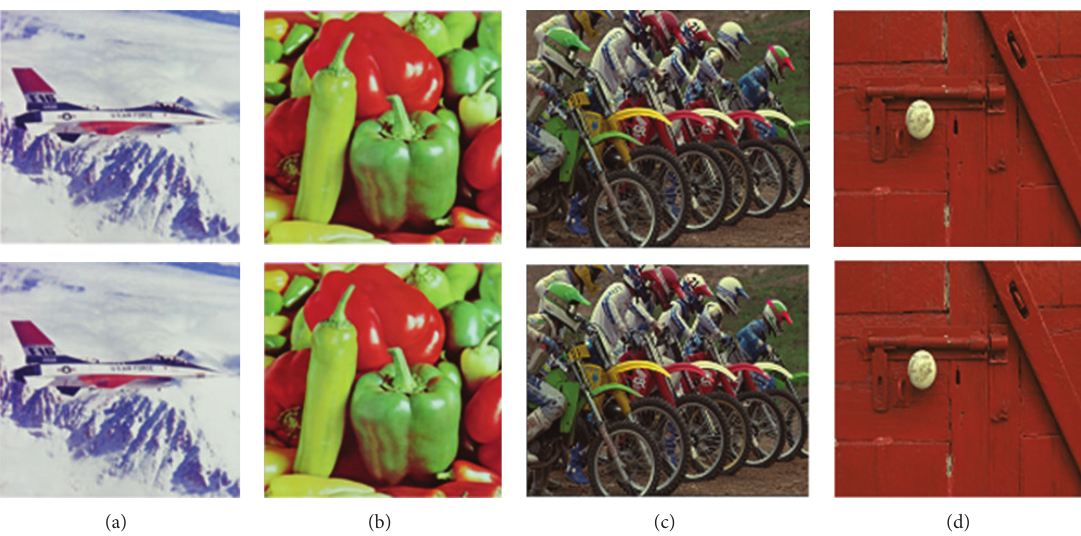
Figure 7: Comparison with H.264/AVC with QP = 24. (a) Jet (25% removal); (b) peppers (32.5% removal); (c) kodim05 (23% removal); (d) kodim02 (51% removal). The top row shows the reconstructed images by proposed scheme and the bottom row shows the reconstructed images by H.264/AVC Intracoding.